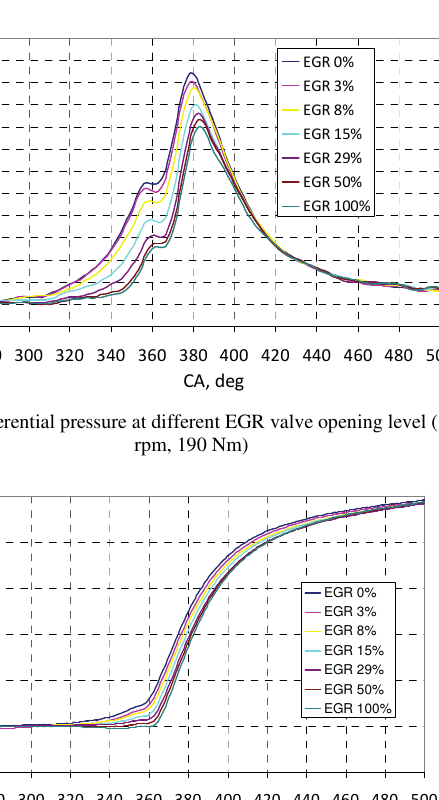
Fig. 7. Differential pressure at different EGR valve opening level (1000 rpm, 190 Nm)